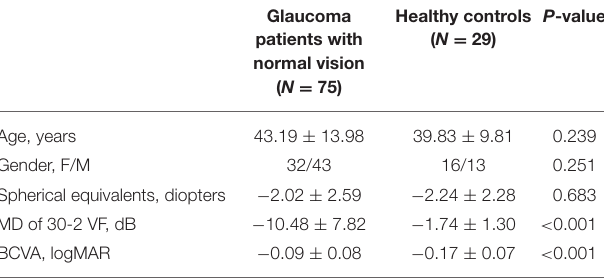
TABLE 2 | Characteristics of the glaucoma patients with normal vision and the healthy